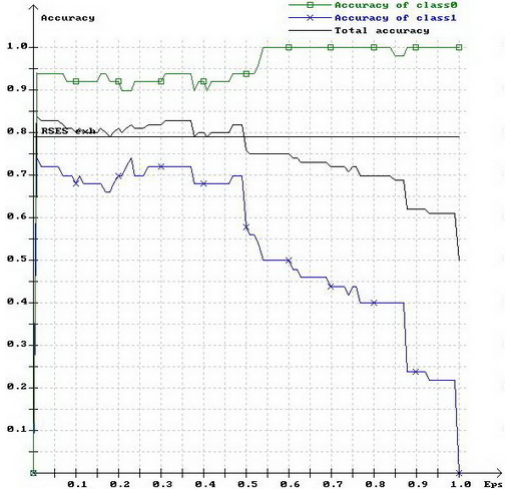
Fig. 3. Results of voting by rules. Best result for ε = 0 . 01, accuracy = 0.84, coverage = 1